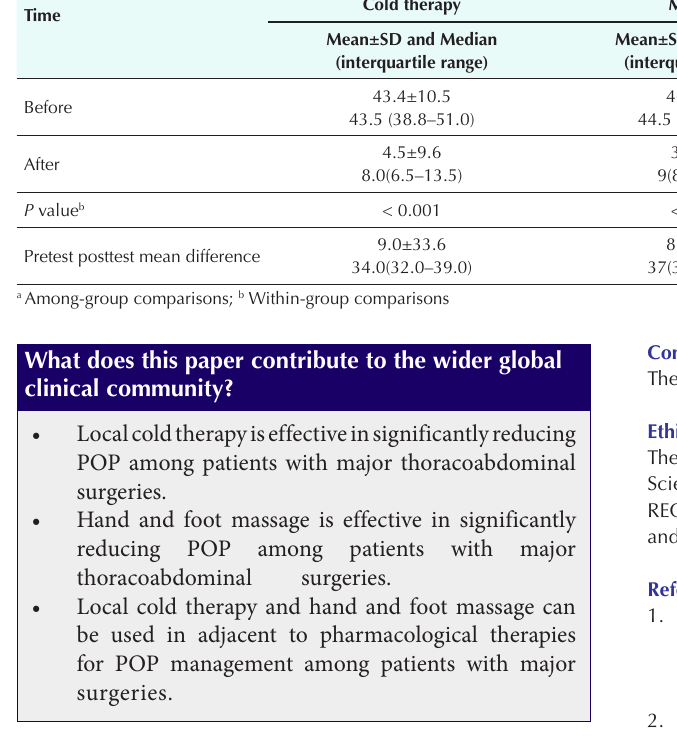
Table 2. Within- and among-group comparisons respecting the mean score of postoperative pain Time